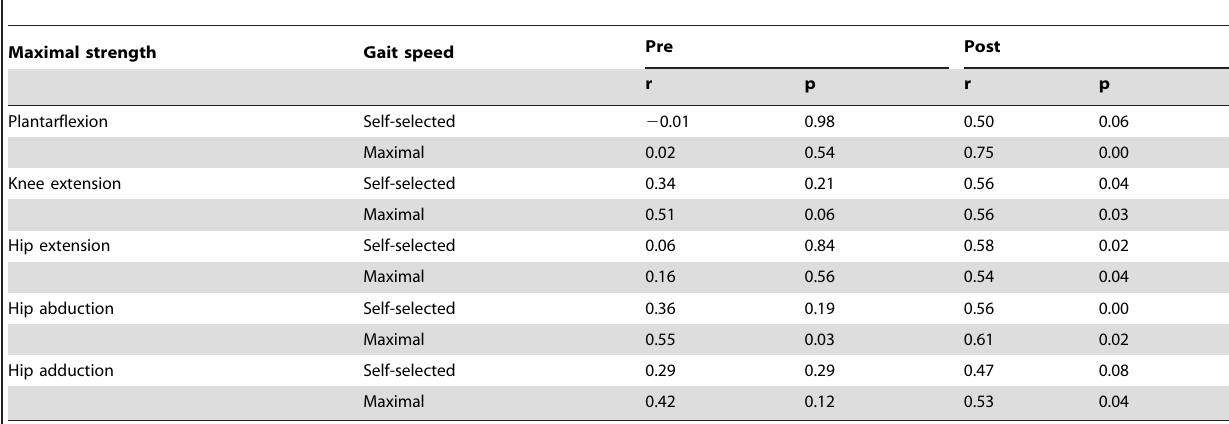
Table 3. Pearson product moment correlation coefficients between maximal leg strength and gait speed before and after exercise intervention (n=15).